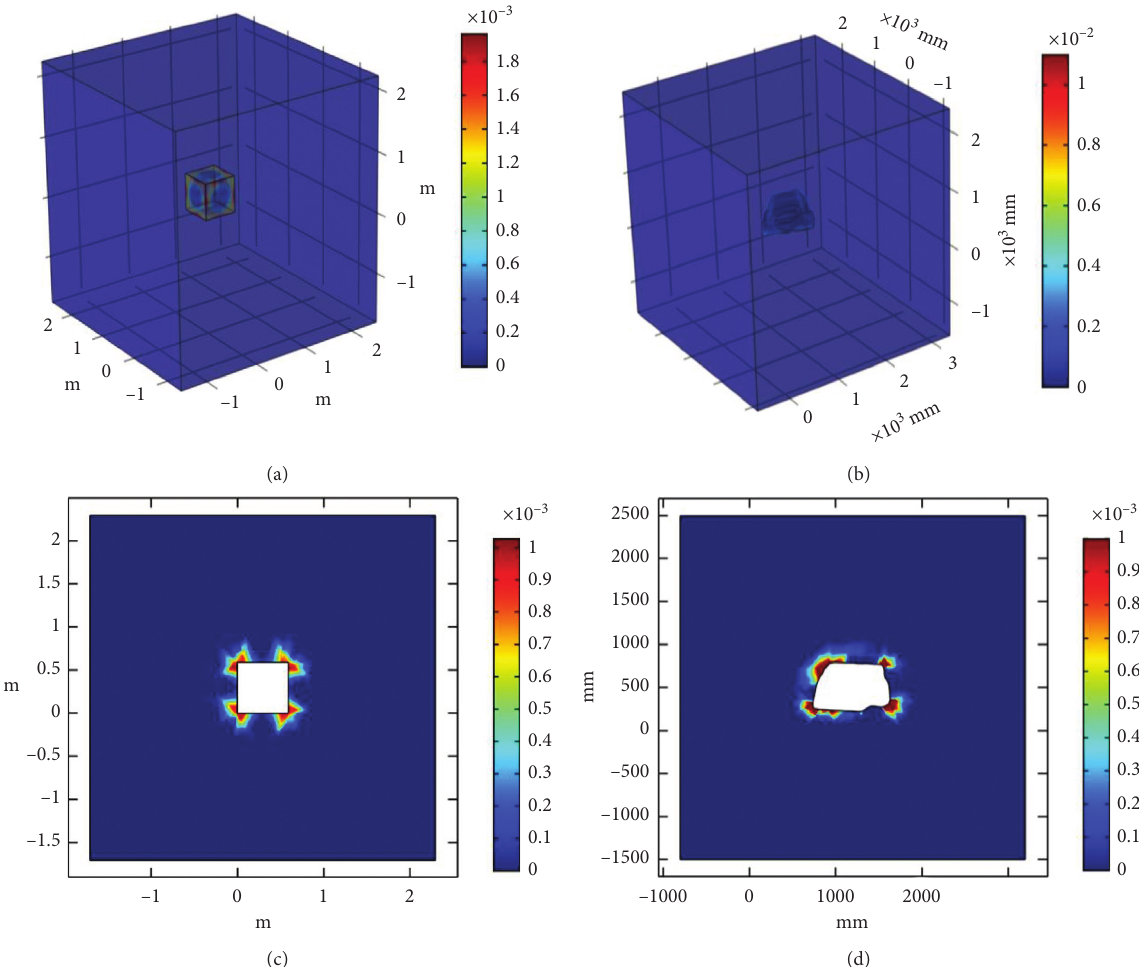
Figure 16: Equivalent plastic strain field of (a) 3D profile using cube model; (b) 3D profile using the cube-like model; (c) 2D profile using cube model; and (d) 2D profile using the cube-like